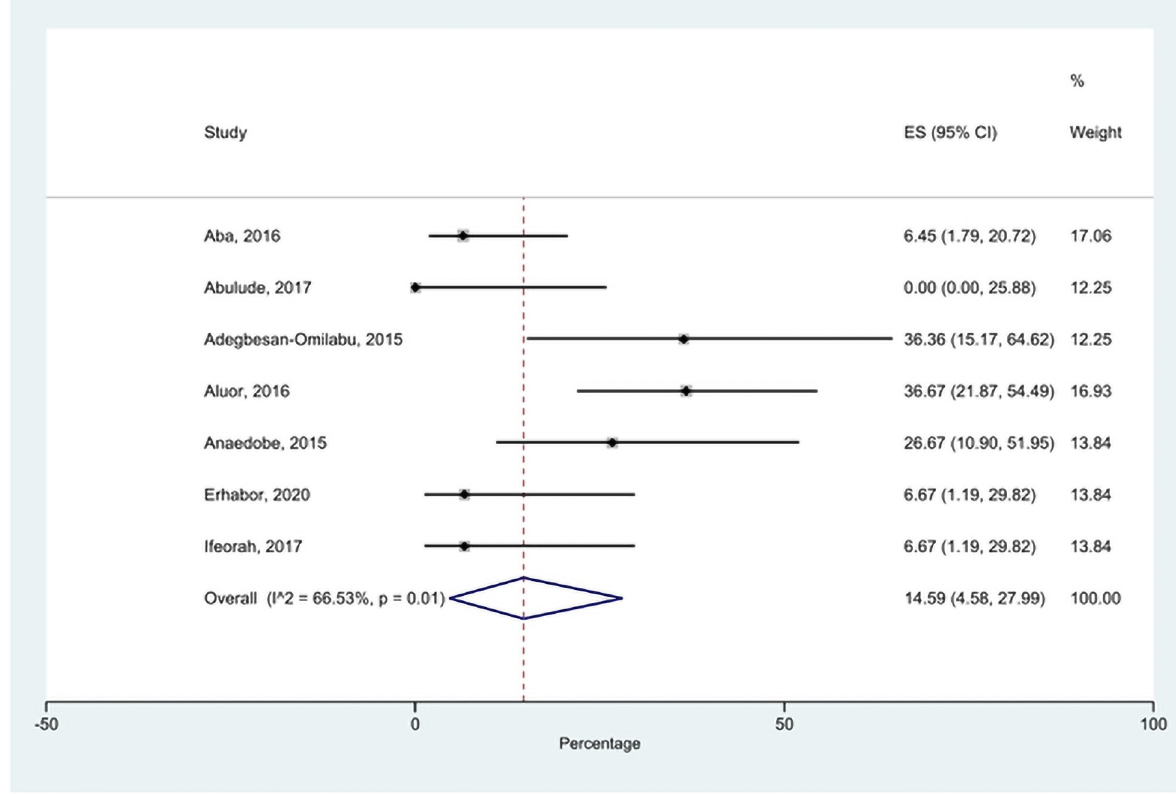
Fig 3. Forest plot of HBeAg prevalence among HBV-infected pregnant women in Nigeria.